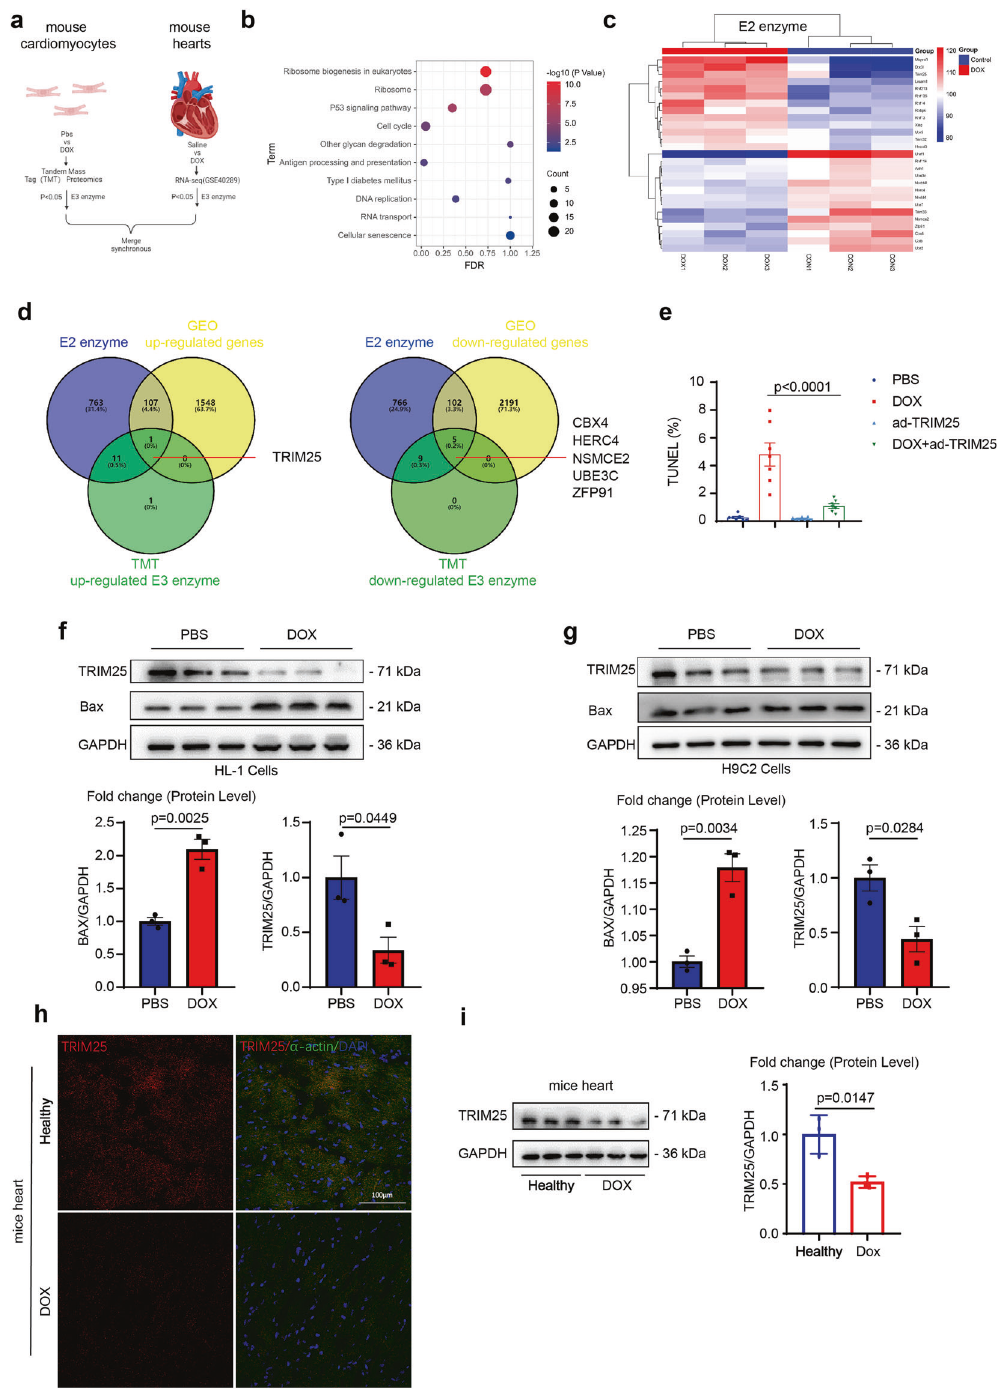
Fig. 1 Ubiquitin E3 ligase TRIM25 level is decreased in DOX-treated cardiomyocytes. a Scheme showing the procedure of identifying ubiquitination-associated targets in DOX-induced cardiotoxicity. b Kyoto Encyclopedia of Genes and Genomes pathway mapping of differentially expressed proteins of DOX-treated cardiomyocytes and control cardiomyocytes. c Hierarchical clustering heatmap of the pro fi le of differentially expressed genes from cardiomyocytes between DOX and phosphate ‐ buffered saline hearts. d Venn diagram showing differentially expressed ubiquitin-related targets consistent in cell and tissue models. e Percentage of TUNEL-positive nuclei in neonatal mouse ventricular myocytes (NMVMs) of each experimental group. f, g Western blot analysis of TRIM25 and Bax in HL-1 and H9C2 cells treated by DOX for 6 h. h Localization and quanti fi cation of TRIM25 (red) in heart sections from mice treated by DOX for 6 h by confocal laser scanning immuno fl uorescence. The nucleus is labeled by DAPI (blue). i Western blot analysis of TRIM25 levels from the hearts of mice treated by DOX for 6 h. Experiments were independently repeated three times. Data are represented as the means ± SEM. P values were determined by using one-way ANOVA with Bonferroni post hoc test ( d ) and unpaired two-tailed Student ’ s t test ( n = 4, C) ( n = 3, J). Scale bar, 100 μ m in I. DOX, doxorubicin; CON, control; NS not signi fi